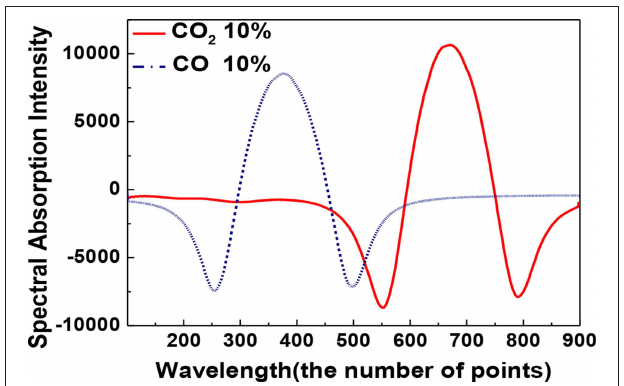
FIGURE 10 | CO and CO 2 absorption near 1,580nm experimentally collected absorption spectra.